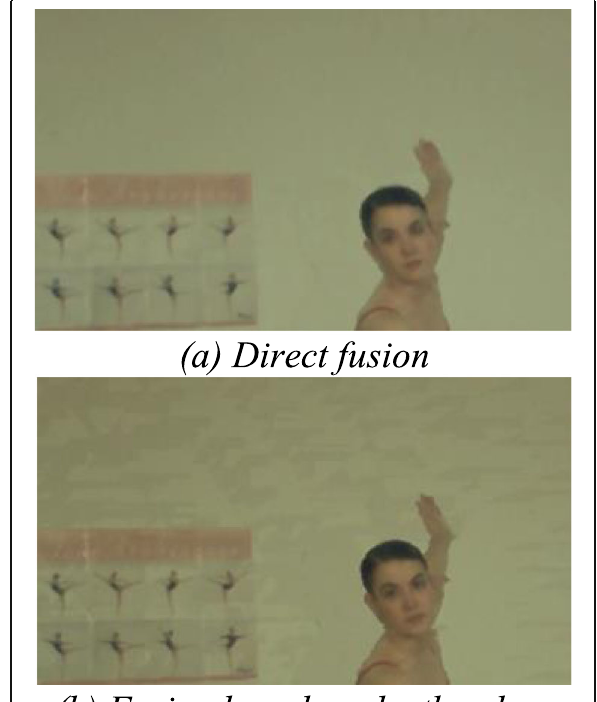
Fig. 5 Comparison of two fusion methods. a Direct fusion. b Fusion based on depth values